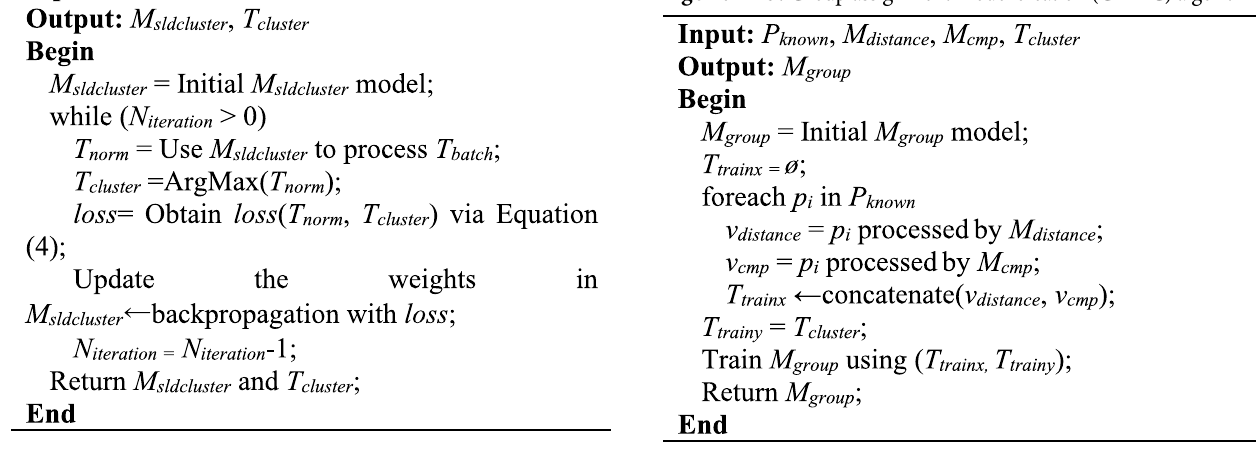
Algorithm 3. Group assignment model creation (GAMC) algorithm.